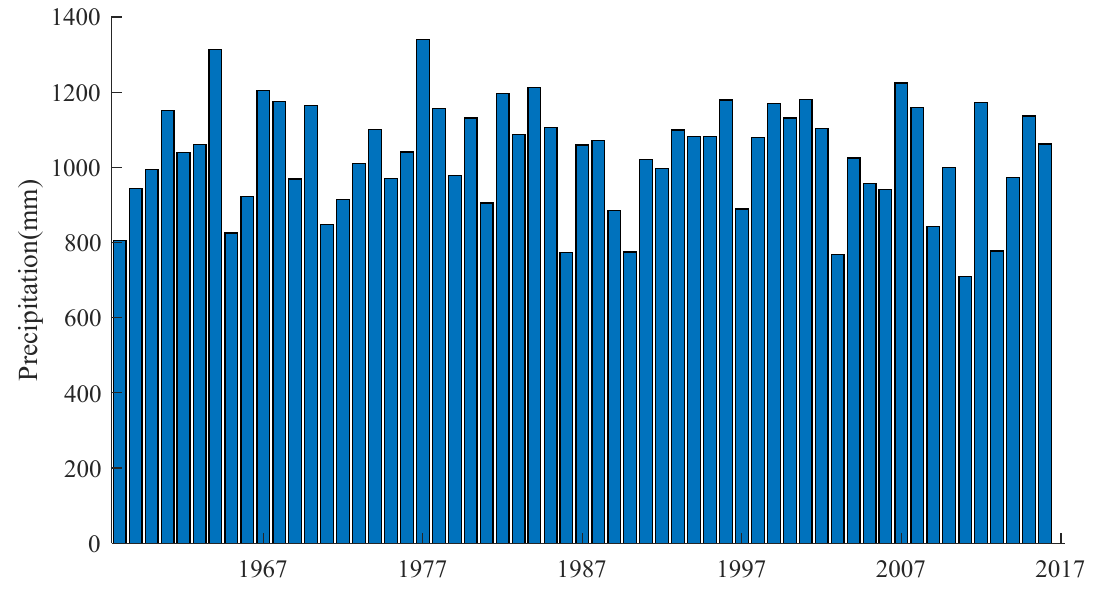
Figure 2. Original annual precipitation data of Jinsha weather station. Table 1. Input variables for different